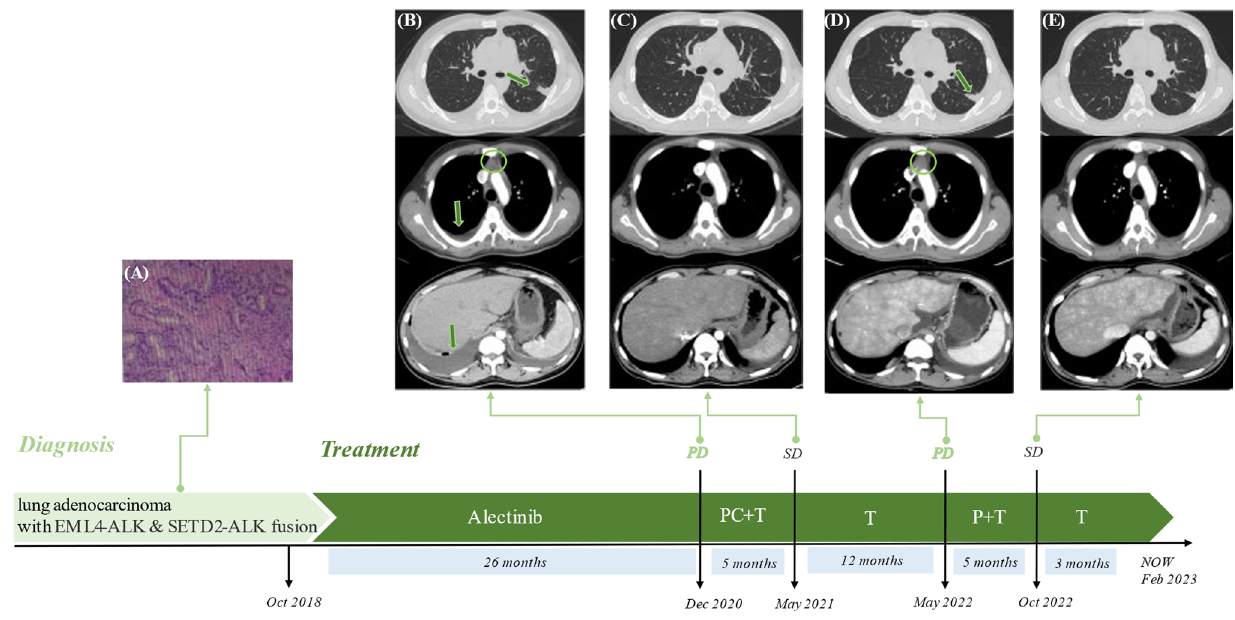
Fig. 2 Time axis of diagnosis and